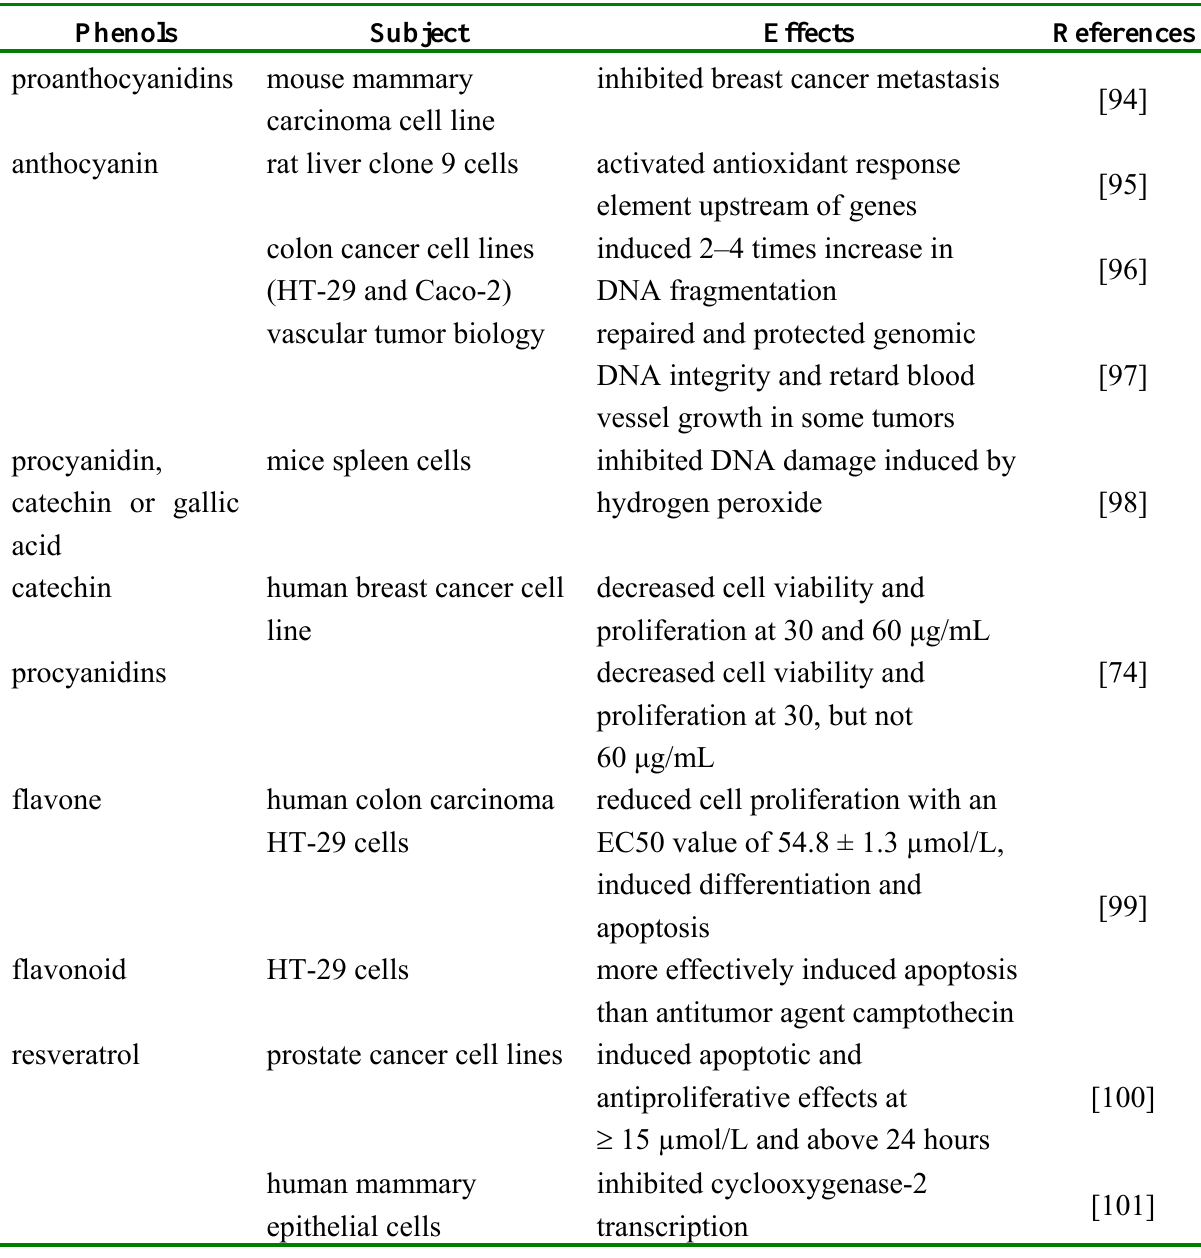
Table 4. Anticancer activities of phenolic compounds from